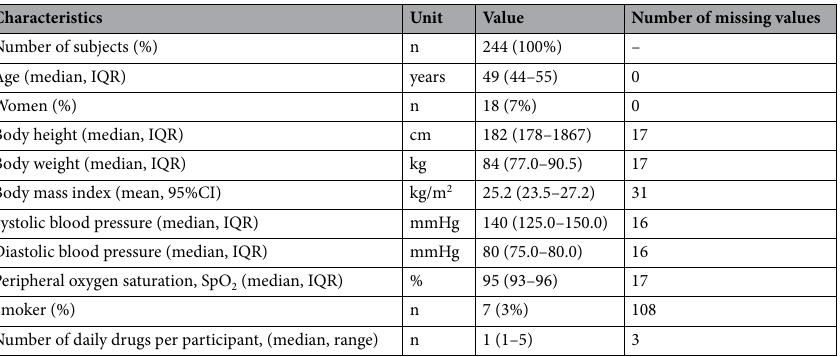
Table 1. Subject characteristics. cm centimeter, IQR Interquartile range, kg kilogram, mmHg unit millimeter of mercury, NA number of missing values, %